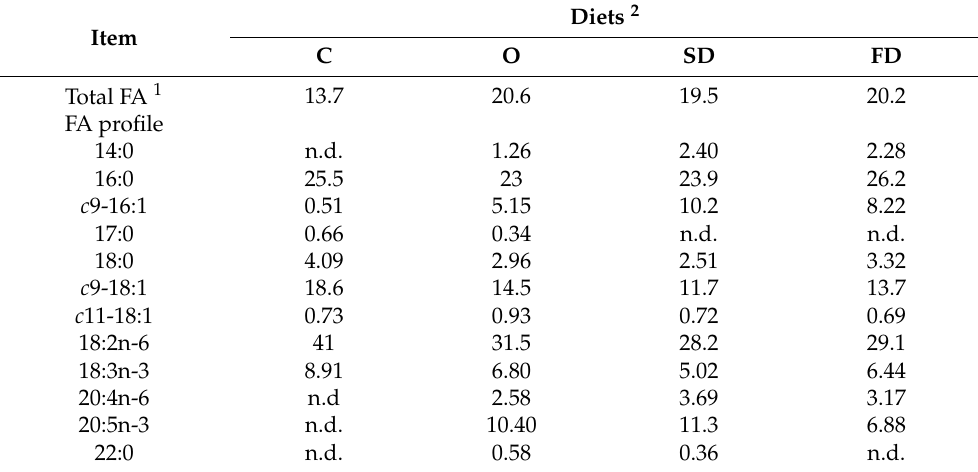
Table 1. Total fatty acid content (g/kg dry matter) and fatty acids (FAs) profile (% of total fatty acids) of the experimental